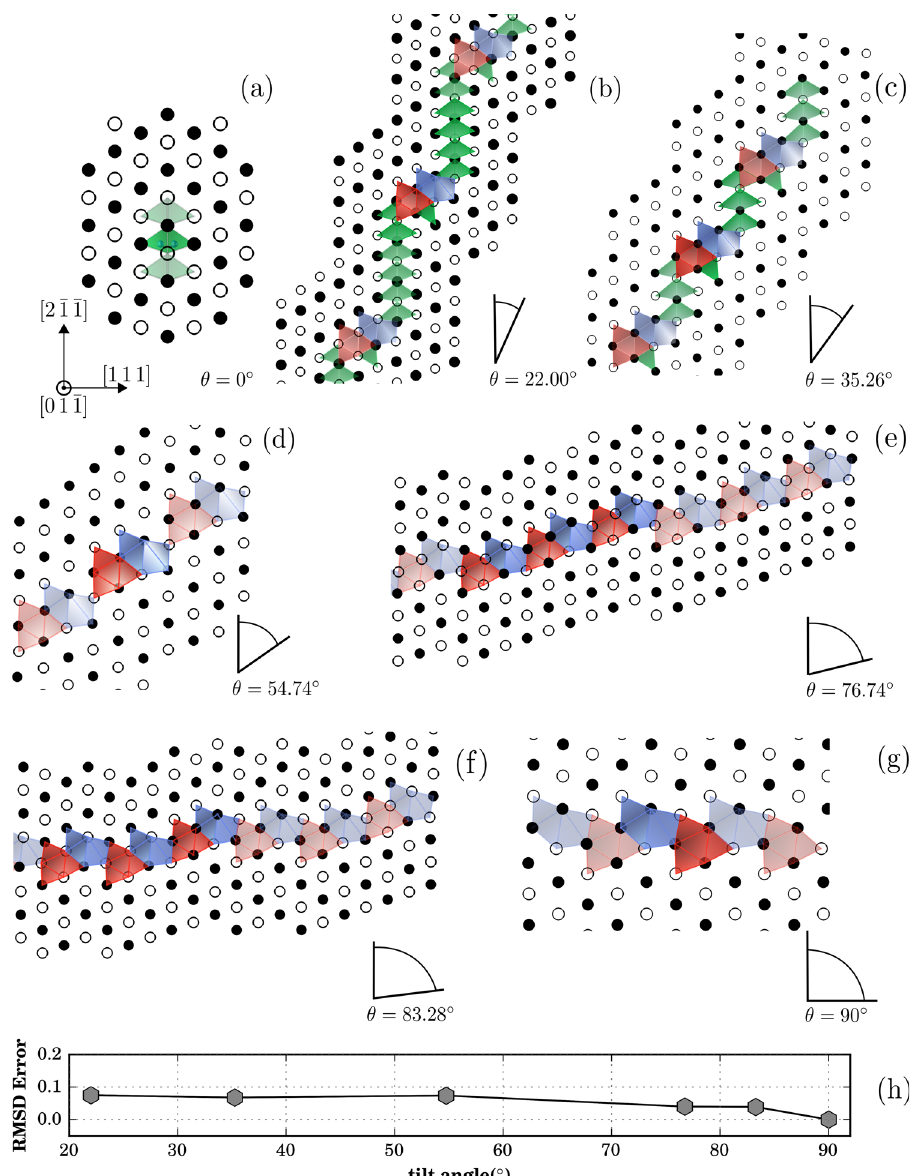
Fig. 10 The polyhedral unit structures of the Σ 3 asymmetric tilt GBs, along the ½ 011 (cid:5) tilt axis, are shown. The order of the GBs are as follows: a Σ 3(111), b Σ 3(11,5,5), c Σ 3(411), d Σ 3(100), e Σ 3 ð 722 Þ , f Σ 3 ð 13 ; 5 ; 5 Þ , and g Σ 3 ð 211 Þ . The faceting model is apparent in the GBs shown in b and c , which contain polyhedral units of both the Σ 3(111) and Σ 3 ð 211 Þ GBs. d – f While there are no twin facets, deviations in boundary-plane orientations are accommodated by sliding the CTP units over the distorted octahedra. An example of this is shown in Figure S29 of the Supplementary Information. h The distortion of the CTP units, when compared to a similar unit in the Σ 3 ð 211 Þ GB, is quanti fi ed and plotted against the tilt angle